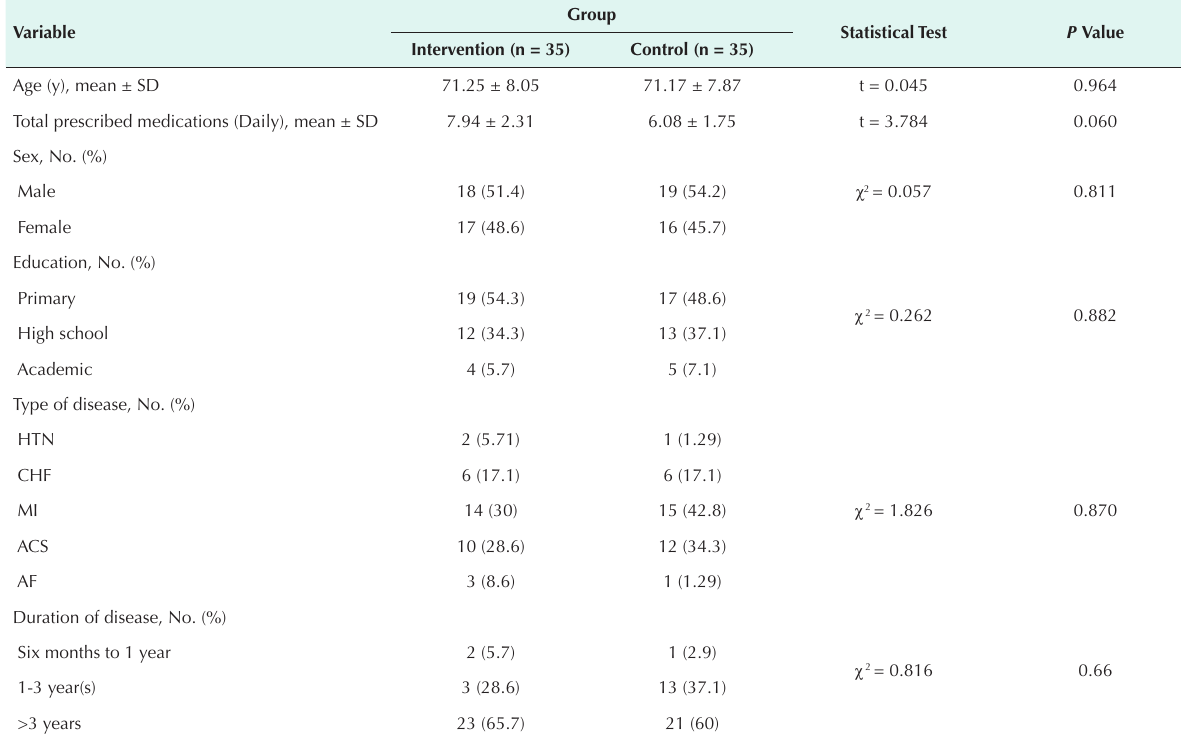
Table 1. Participants’ Baseline Demographic and Clinical Characteristics